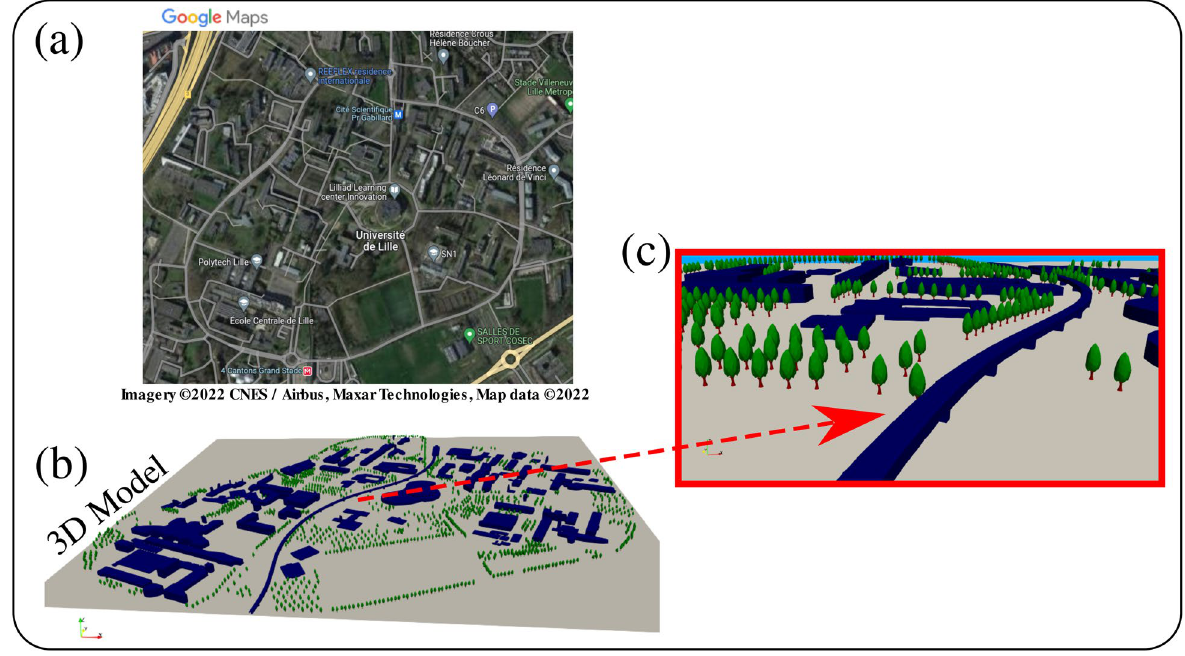
Figure 11. The integration of large trees into the 3D model of Fig. 9. ( a ) A green 2D map from google- maps; ( b ) constructed 3D model showing the implanted 1187 large trees; ( c ) a zoom-in perspective view showing some campus buildings, large trees and subway metro